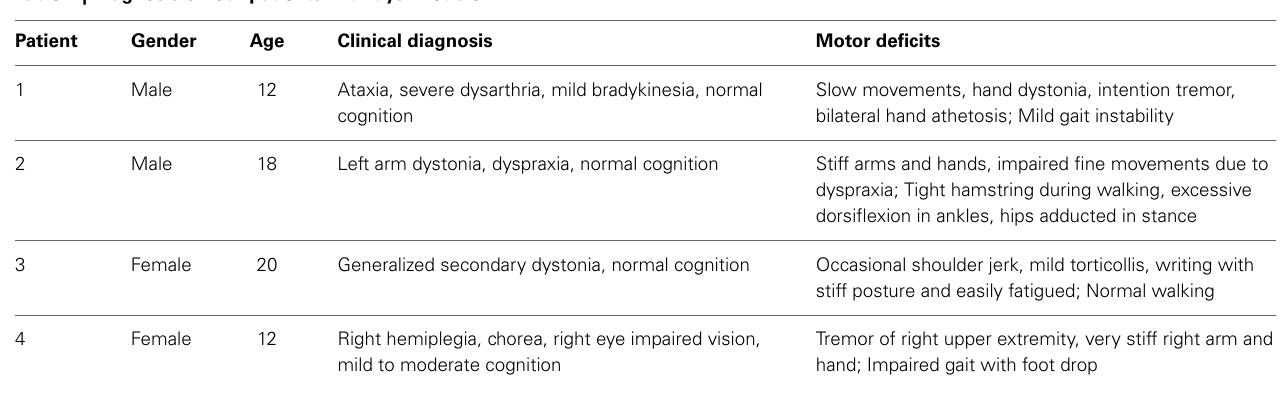
Table 1 | Diagnosis of four patients with dyskinetic